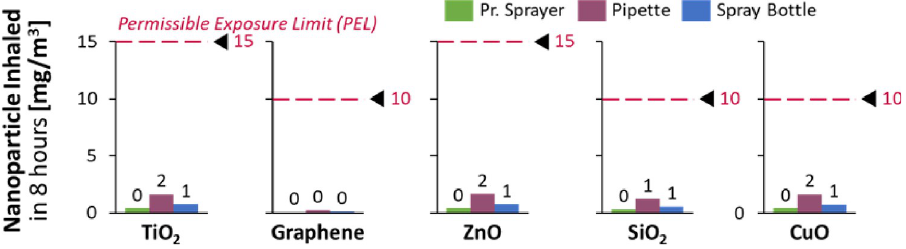
Fig 8. The dislodged nanoparticles are well within their Permissible Exposure Limits.